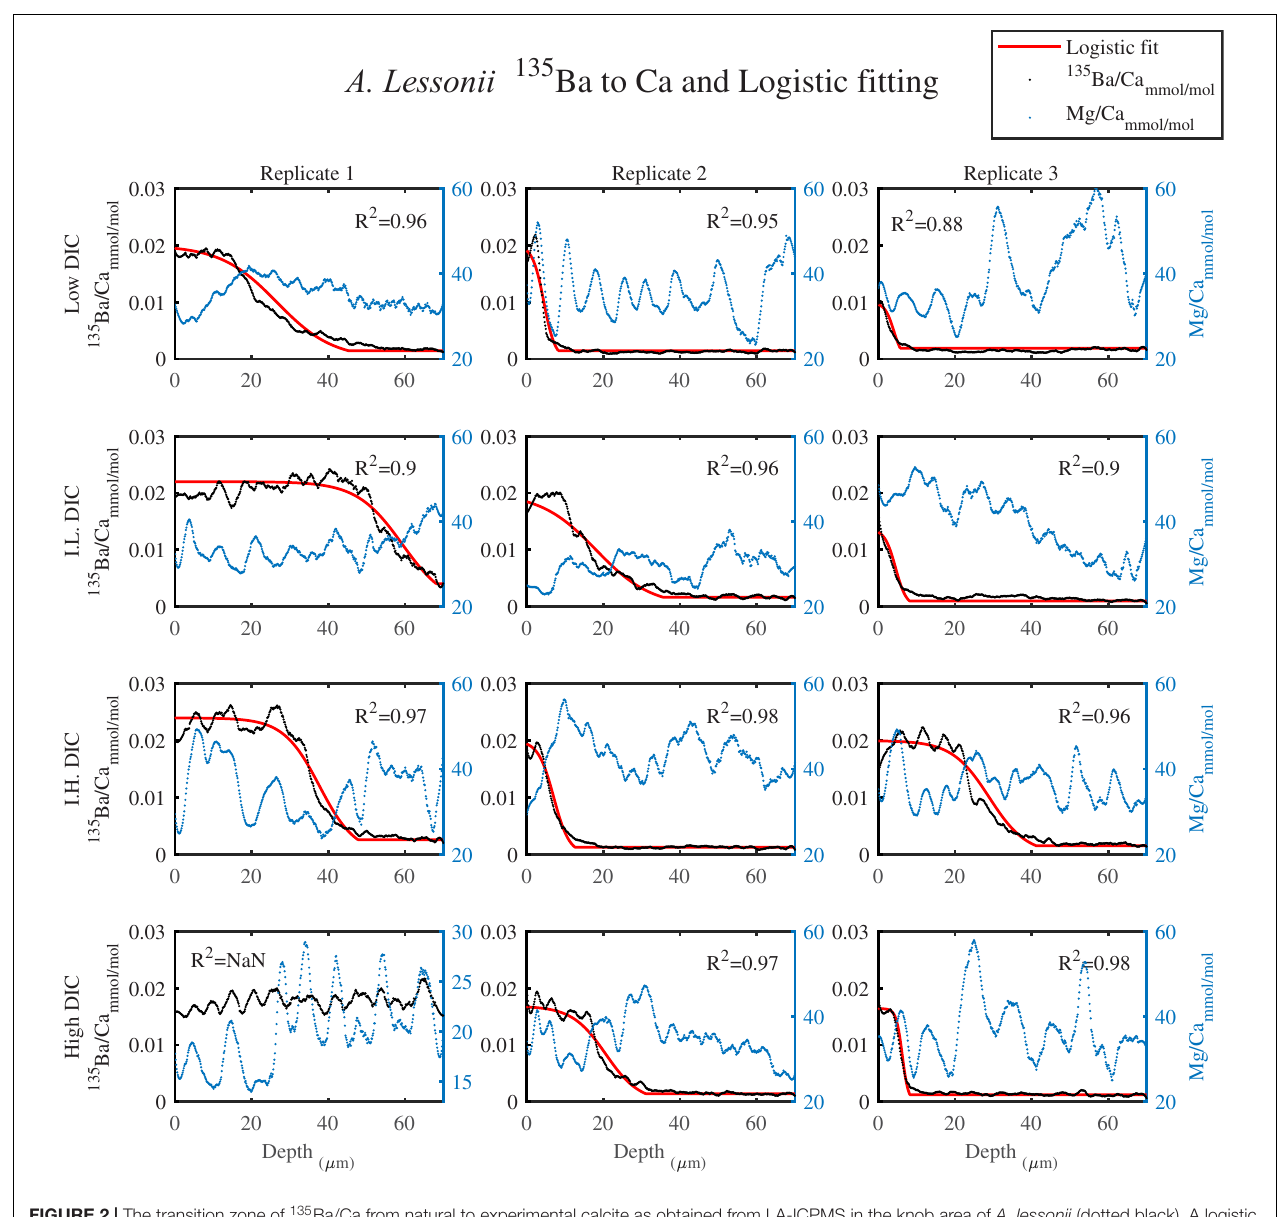
FIGURE 2 | The transition zone of 135 Ba/Ca from natural to experimental calcite as obtained from LA-ICPMS in the knob area of A. lessonii (dotted black). A logistic population function was fitted to the data (red solid line). The correlation coefficients of the fitted lines are very high ( R 2 > 0.9). The dotted blue line is the Mg/Ca ratio and the high peaks represent new chambers growth. Note that there is no correlation between the newly grown calcite (high 135 Ba) and the experimental DIC conditions. Replicates L3 and IL3 stopped growing in the middle of the transition zone and replicate H1 shows only new growth.